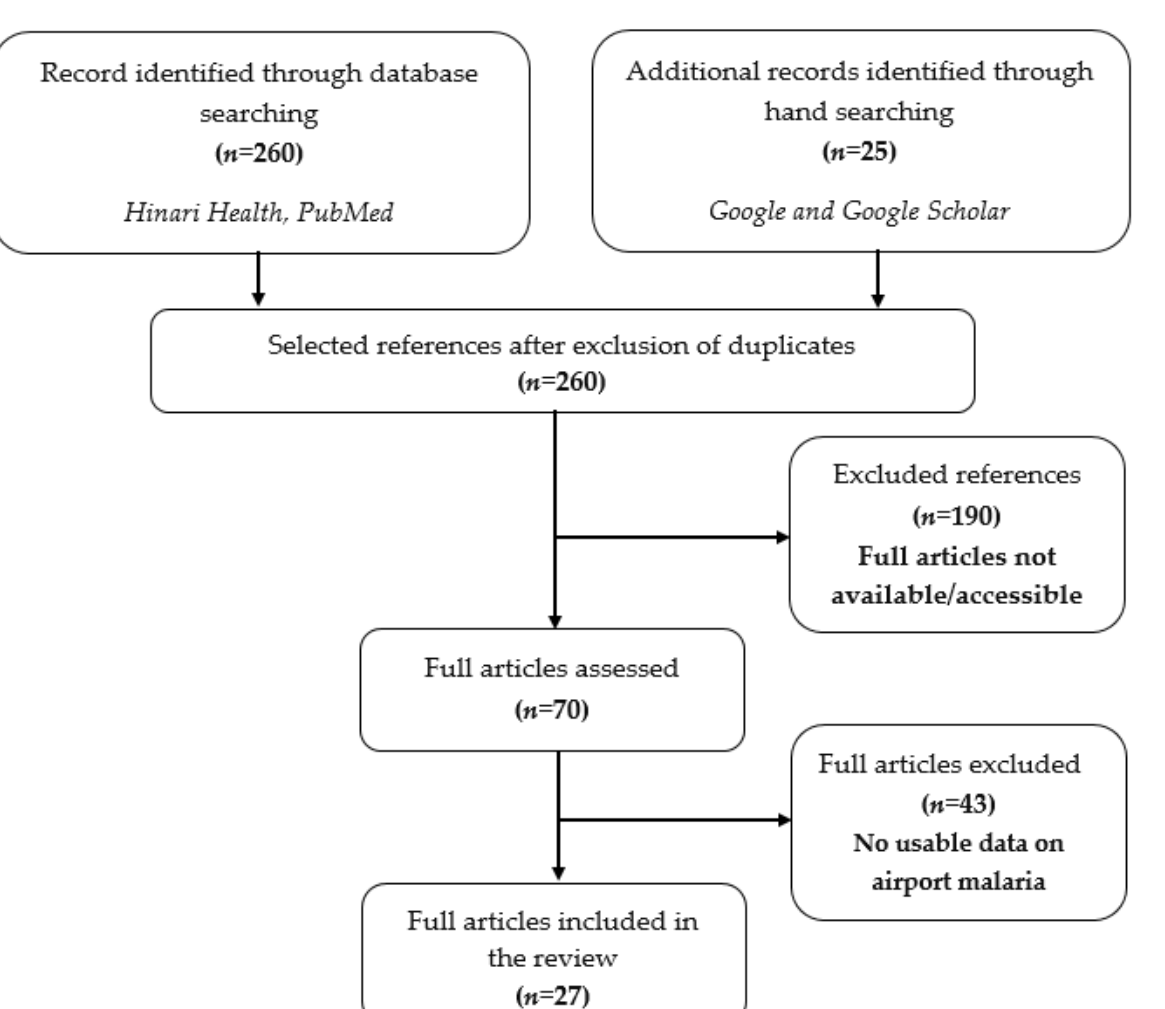
Figure 1. PRISMA chart showing the steps for the selection of articles.